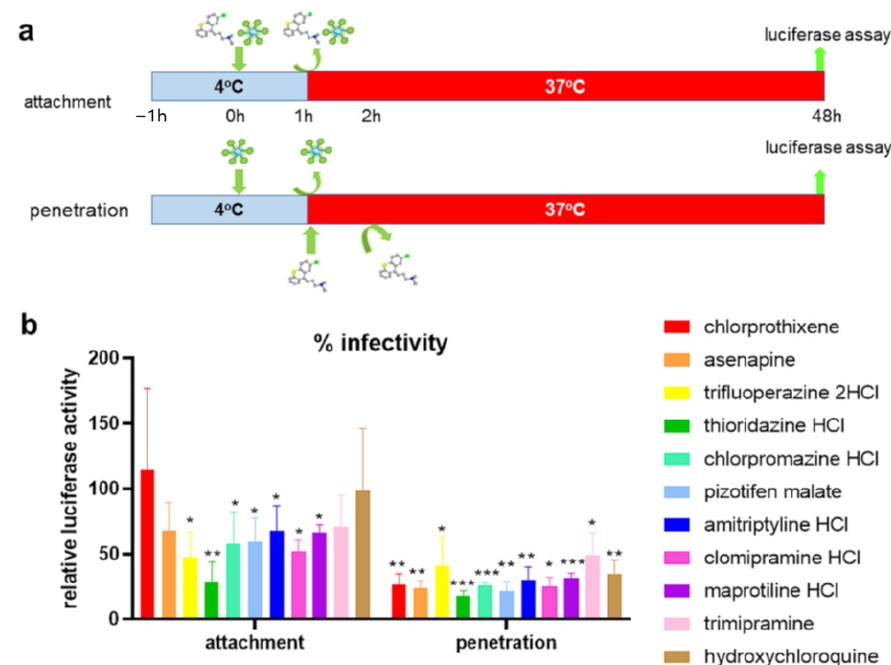
Figure 6. Kite-shaped molecules inhibit SARS-CoV-2 pseudovirus at post-attachment steps. Mouse leukemia virus pseudotyped with spike protein (S) from severe acute respiratory syndrome coronavirus-2 was used to infect 293T-ACE2 cells in 96-well plates for 48 h in a temperature shift experiment. ( a ) Schematic of temperature shift experiment. Cells were pre-cooled for an hour. In the attachment assay, 10 µ M of drug diluted in pre-cooled virus aliquots was added to infect for an hour on ice. After 1 h, drug and virus were washed off and cells rinsed 3× with cold medium. Fresh, warm medium was added, and cells incubated for the remaining 48 h at 37 °C. In the penetration assay, pre-cooled virus without drug was added to cells at 4 °C. The virus was washed off after 1 h and cells rinsed 3× with ice-cold medium. Drug in warm medium was then added to incubate with cells for 1 h at 37 °C. The drug was then washed off with warm PBS (without Mg 2+ and Ca 2+ ) and rinsed with warm medium. Fresh, warm medium was added to continue incubation for the rest of 48 h. Addition of drug is represented by a drug image obtained from PubChem. ( b ) Infectivity was measured as luciferase activity and expressed as % infectivity to infected, own solvent control (dimethyl sulfoxide, ethanol, or water). Data are presented as mean ± SD of four repeats for attachment assays and three repeats for penetration assays. Statistically significant differences are represented by * p < 0.05, ** p < 0.01, and *** p <